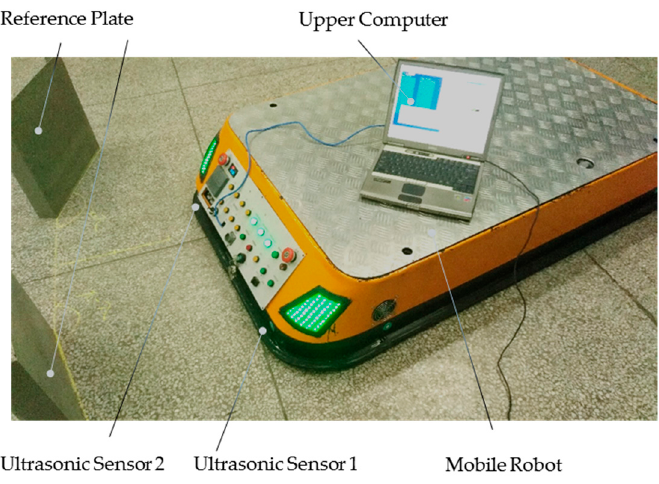
Figure 7. The localization experiment.